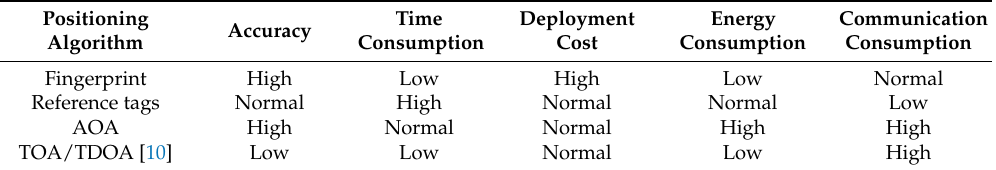
Table 1. Different indoor positioning algorithm